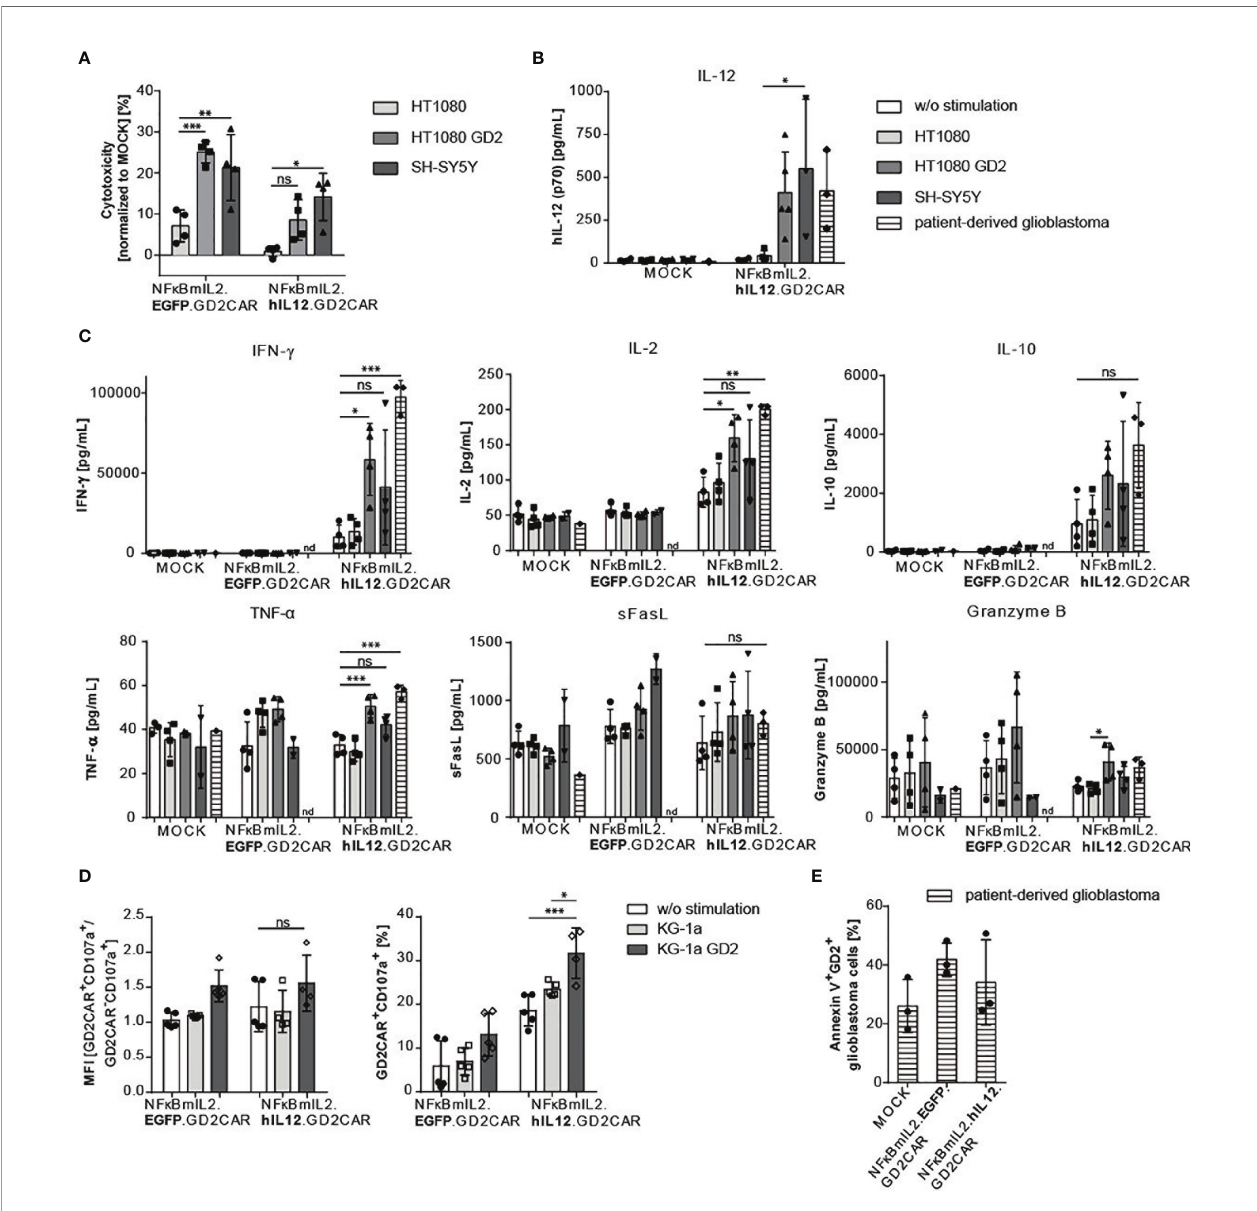
FIGURE 4 | Increased cytotoxic potential of modi fi ed NK-92 cells with NF k B-driven “ all-in-one ” vectors after target gene stimulation. (A) Increased cytotoxic activity after GD2 antigen recognition. GD2CAR-mediated activation leads to antigen-speci fi c killing. Lactate dehydrogenase (LDH) assays were performed with supernatants of coculture experiments. Cocultures were performed with “ all-in-one ” vector-modi fi ed, unsorted (MOI 10) NK-92 cells and indicated target cells for 24 h at an E:T of 6:1. Cytotoxicity was normalized to MOCK cells. Shown are mean values ± SD (n = 4 independent experiments done in triplicates). Indicated signi fi cance was determined by two-way ANOVA with Tukey ’ s multiple-comparison test; ***p ≤ 0.001; **p ≤ 0.01; *p ≤ 0.05; ns, not signi fi cant. (B) Increased IL-12 secretion after GD2CAR-mediated stimulation. Bar graphs show inducible IL-12 secretion measured by ELISA of unsorted modi fi ed (MOI 10) NK-92 cells after 24 h of cocultivation with indicated target cell lines (E:T 10:1) or primary patient-derived GBM (n = 3 – 5). (C) Cytokine pro fi le (IFN- g , IL-2, IL-10, TNF- a , sFasL, and Granzyme B) of NK cell-speci fi c activation markers after a 24-h coculture of unsorted modi fi ed (MOI 10) NK-92 cells and indicated target cell lines (E:T 10:1) or primary patient-derived GBM analyzed via LEGENDplex ™ assay. Cytokines were determined in cell culture supernatants (n = 3 – 4). (D) Upregulation of the degranulation marker CD107a after GD2CAR-mediated stimulation in unsorted modi fi ed (MOI 10) NK cells cocultured for 24 h with KG-1a or KG-1a GD2 cells. Mean fl uorescence intensity (MFI) of GD2CAR + CD107a + /GD2CAR - CD107a + ratio and percentages of CD107a expression in GD2CAR + NK-92 cells are shown (n = 4 – 5). (E) Enhanced cytolytic potential of unsorted modi fi ed (MOI 10) NK-92 cells after coculture with primary GBM cells measured by Annexin V surface expression to detect apoptotic/necrotic GBM cells (n = 3). Shown are percentages of Annexin V + GD2 + glioblastoma cells. Mean values ± SD are shown in Figure 4 . Indicated signi fi cance was determined by one-way ANOVA with Tukey ’ s multiple-comparison test; ***p ≤ 0.001; **p ≤ 0.01; *p ≤ 0.05; ns, not signi fi cant. Untransduced effector cells were termed